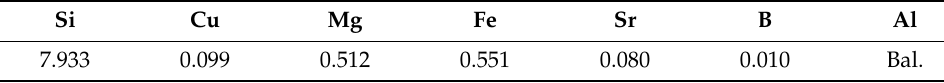
Table 1. Chemical composition of Al-Si-Mg-Cu alloy